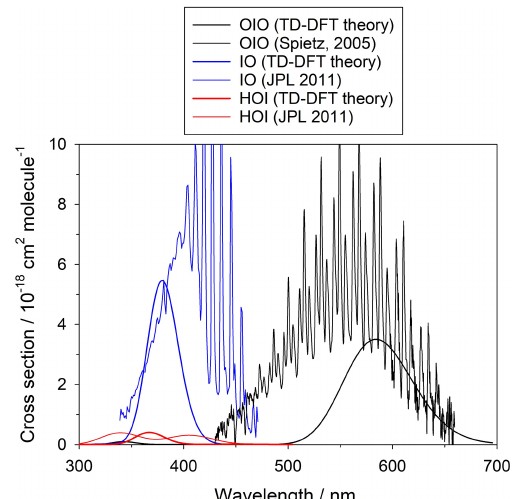
Figure A2. Experimental absorption cross sections of IO (Sander et al., 2011), OIO (Spietz et al., 2005), and HOI (Sander et al., 2011) and absorption spectra calculated with the TD-DFT method (this